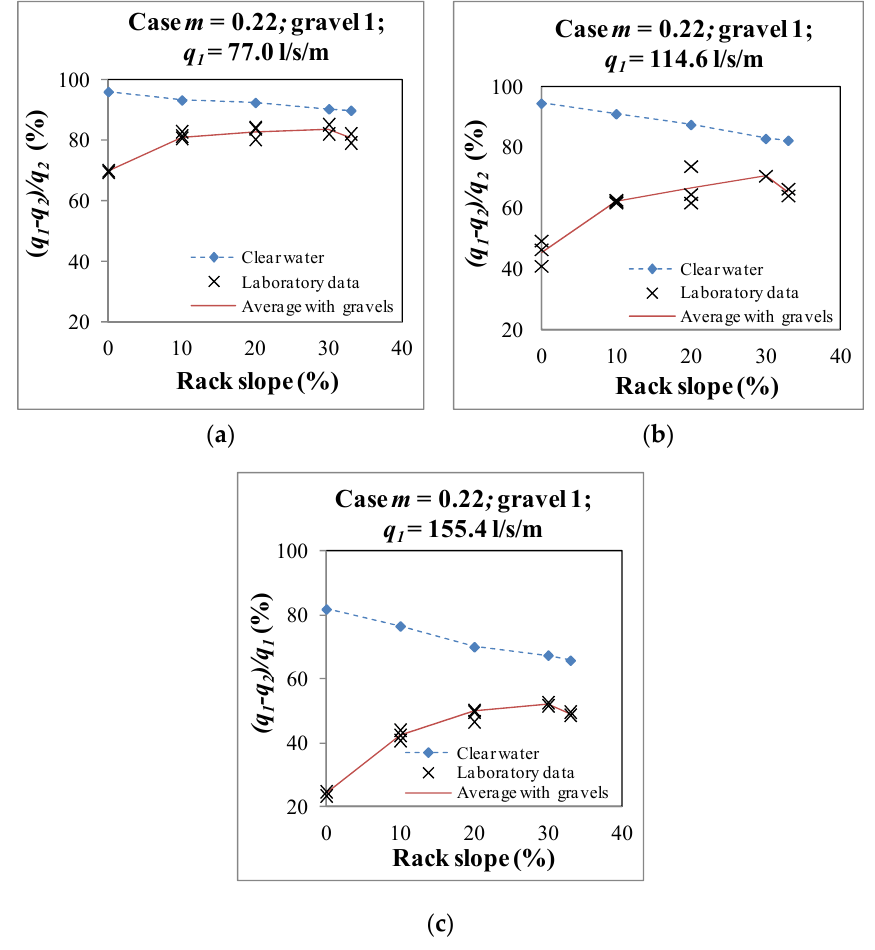
Figure 10. Percentage of material collected by the rack for diverse tests ( a ) q 1 = 77.0 l/s/m, ( b ) q 1 = 114.6 l/s/m, ( c ) q 1 = 155.4 l/s/m.